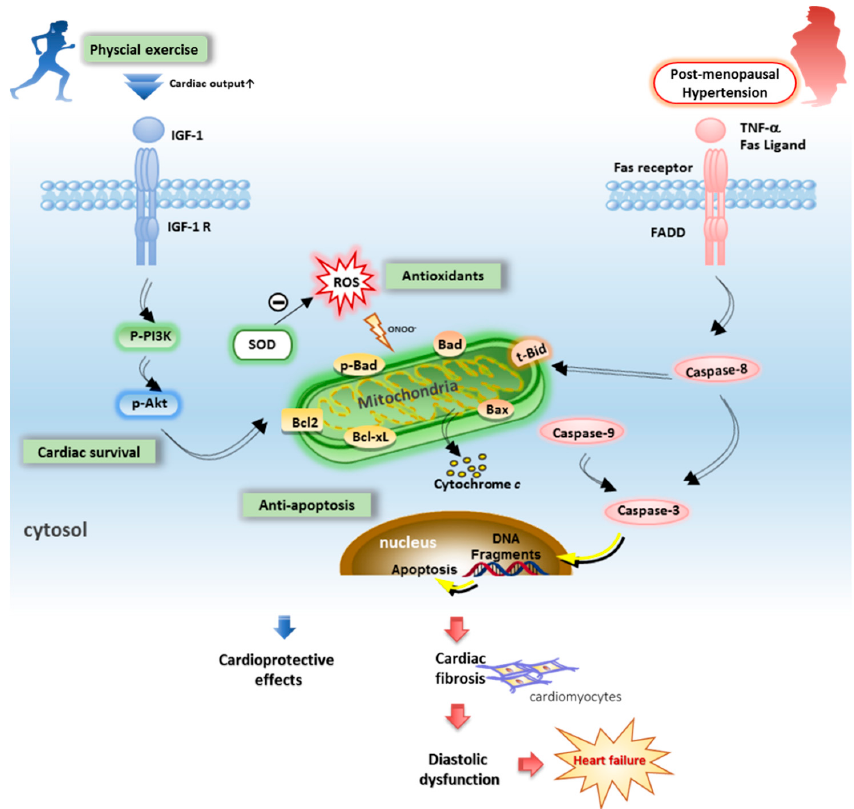
Figure 2. Hypothesized exercise training may improve pathophysiology of heart failure in postmenopausal hypertension. The mechanisms initiating diastolic dysfunction involve the oxidative